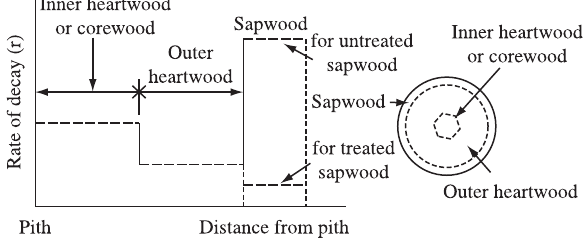
Figure 3. Illustrative scheme of the relative decay rate of different types of wood 9